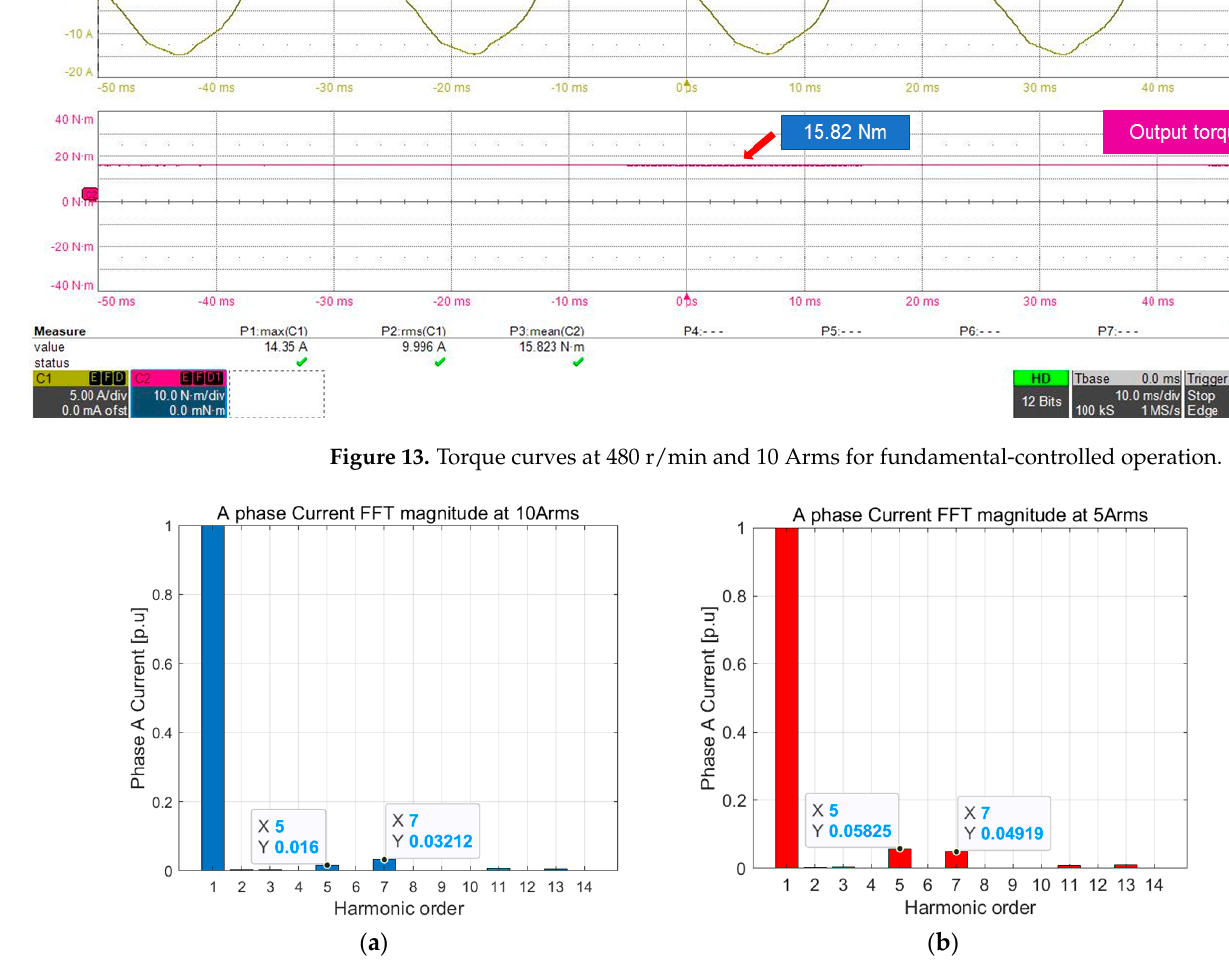
Figure 15. Torque curves at 480 r/min and 5 Arms for fundamental-controlled operation.